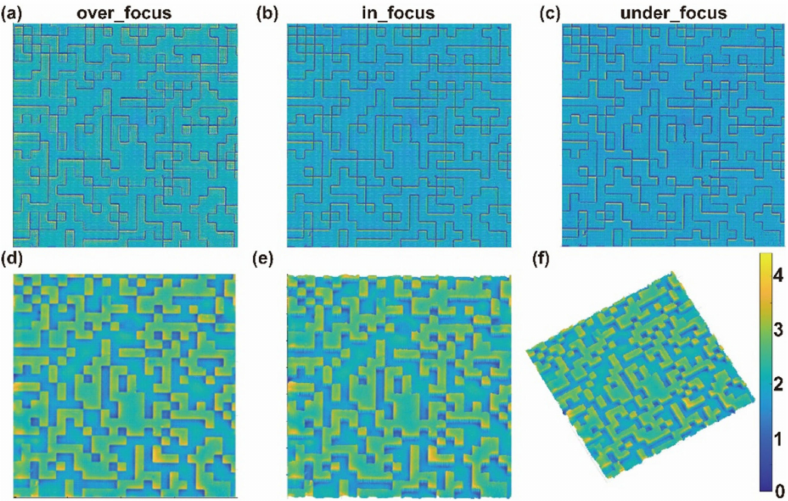
Figure 5. Images and phase distributions of random phase plates. ( a – c ) represent the images of random phase plates with different focal lengths; ( d – c ) the phase distribution of random phase plates at different